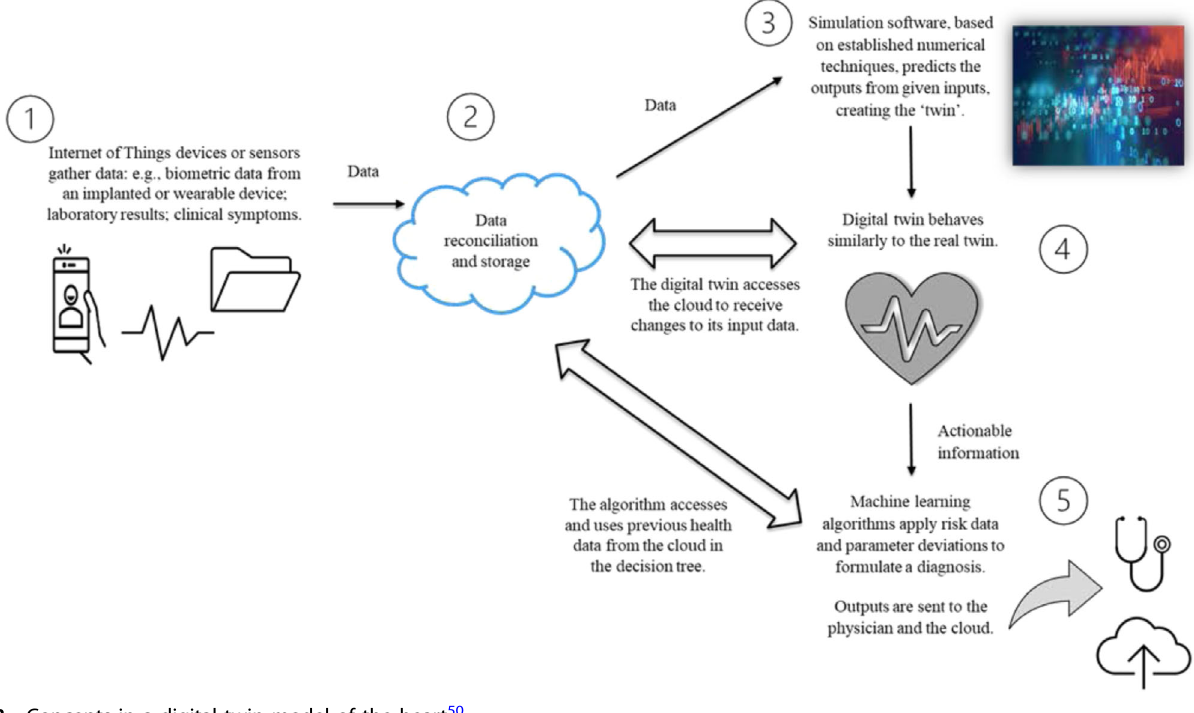
Fig. 3 Concepts in a digital twin model of the heart 50 .